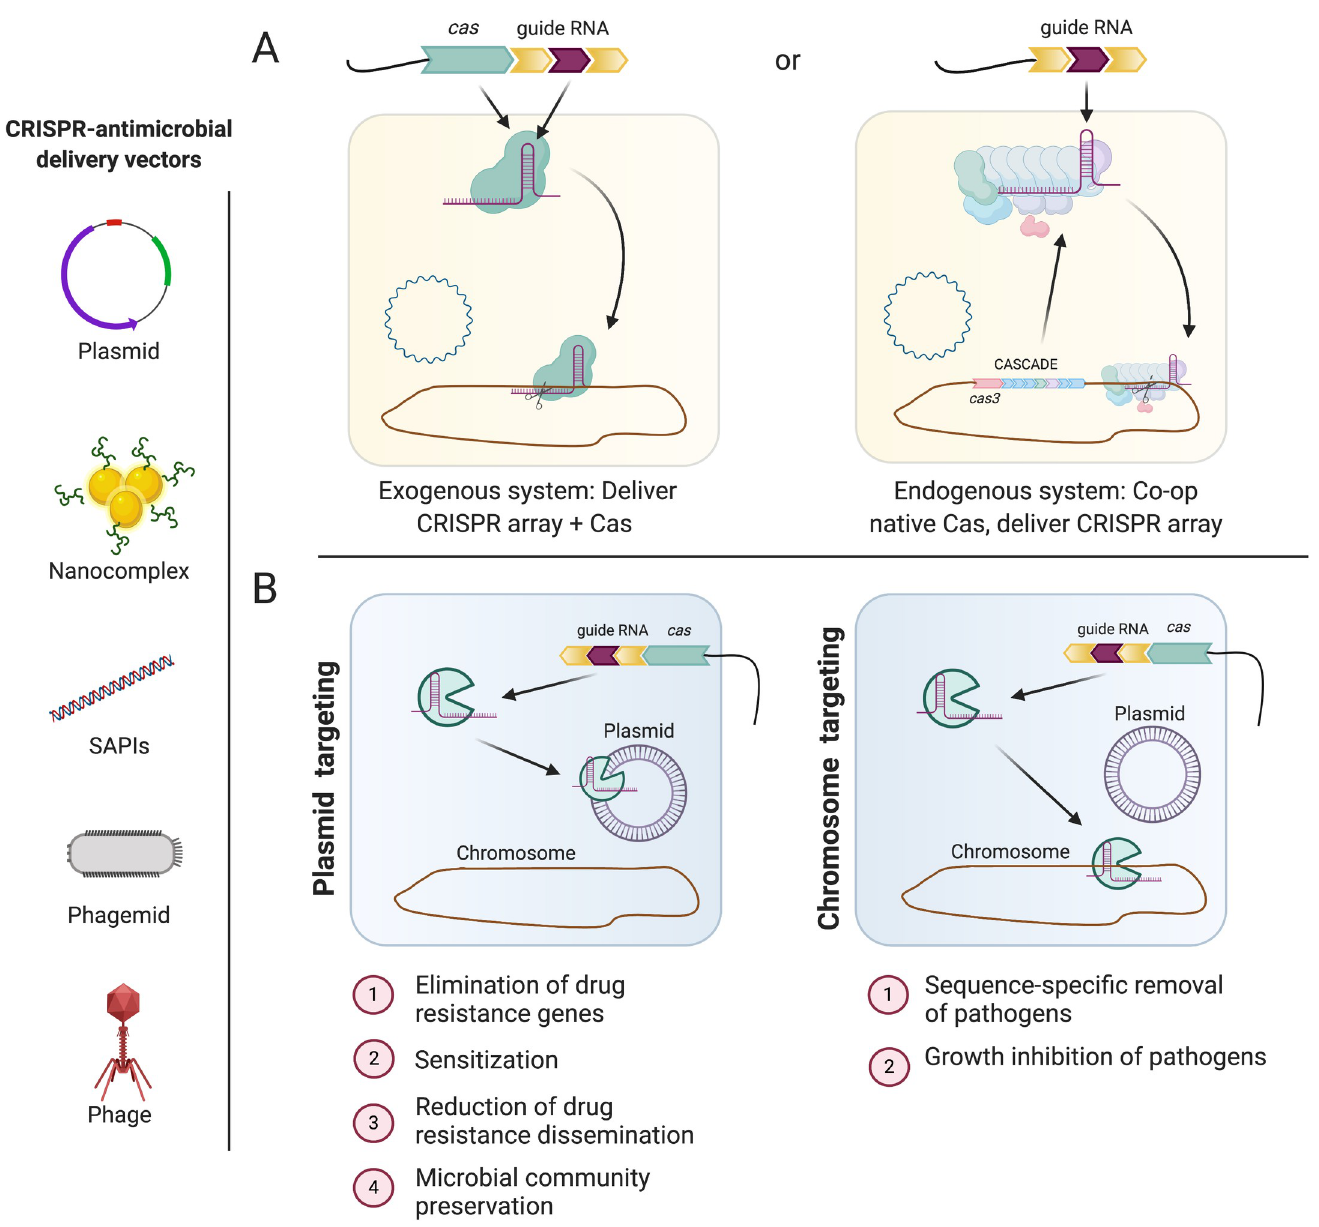
Fig 2. Strategies for the development of CRISPR-based antimicrobials. (A) One approach is to deliver a complete exogenous CRISPR/Cas system to target a desired locus (chromosome or plasmid). Alternatively, if the target pathogen harbors a CRISPR/Cas system, one can deliver a CRISPR array and exploit the native Cas proteins to drive DNA targeting. (B) CRISPR antimicrobials can be designed to target a chromosomal locus, leading to cell death or a plasmid locus, leading to plasmid loss and sensitization of the target bacteria. Left: an array of different CRISPR antimicrobial delivery vehicles proposed by different research groups. Created with BioRender.com. Cascade, CRISPR-associated complex for antiviral defense; CRISPR/Cas, clustered regularly interspaced short palindromic repeats/CRISPR- associated protein; SAPI, staphylococcal pathogenicity